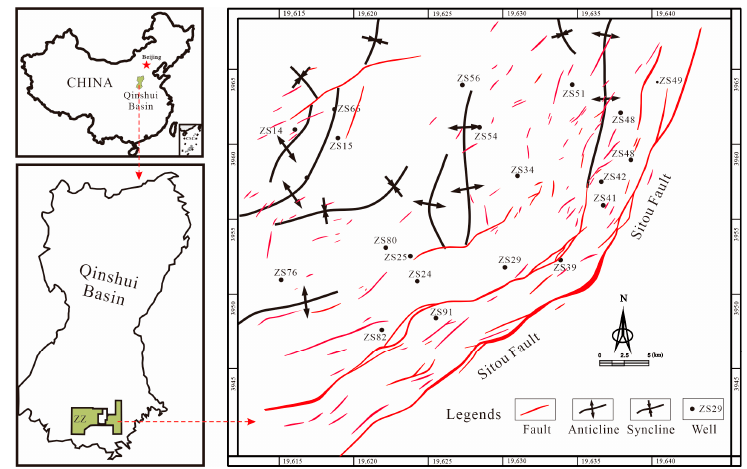
Figure 2. Regional geological characteristics of Zhengzhuang block.